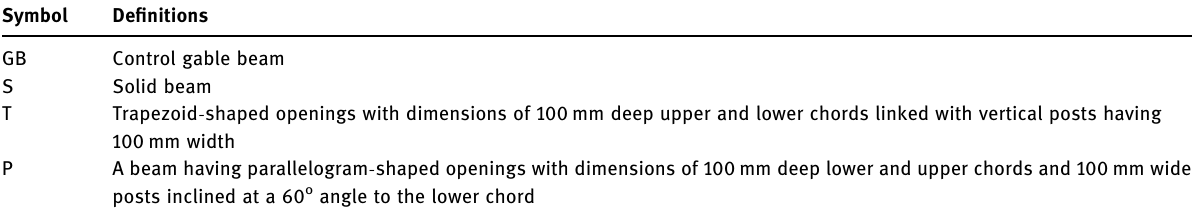
Table 1: De fi nitions of symbols Symbol De fi